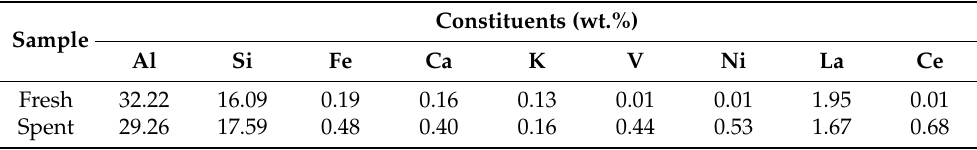
Table 1. Chemical compositions of the fresh and SFCC